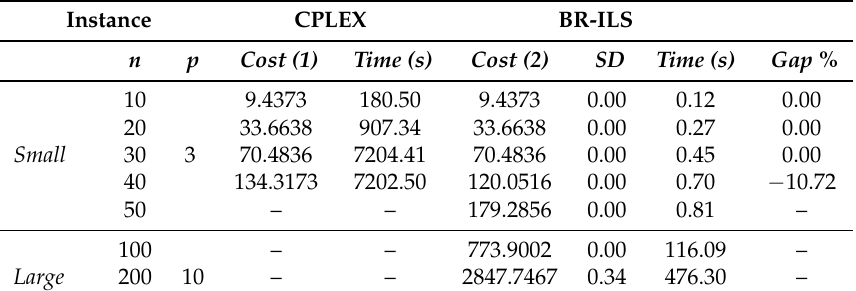
Table 2. Comparison of the results that were obtained with CPLEX and